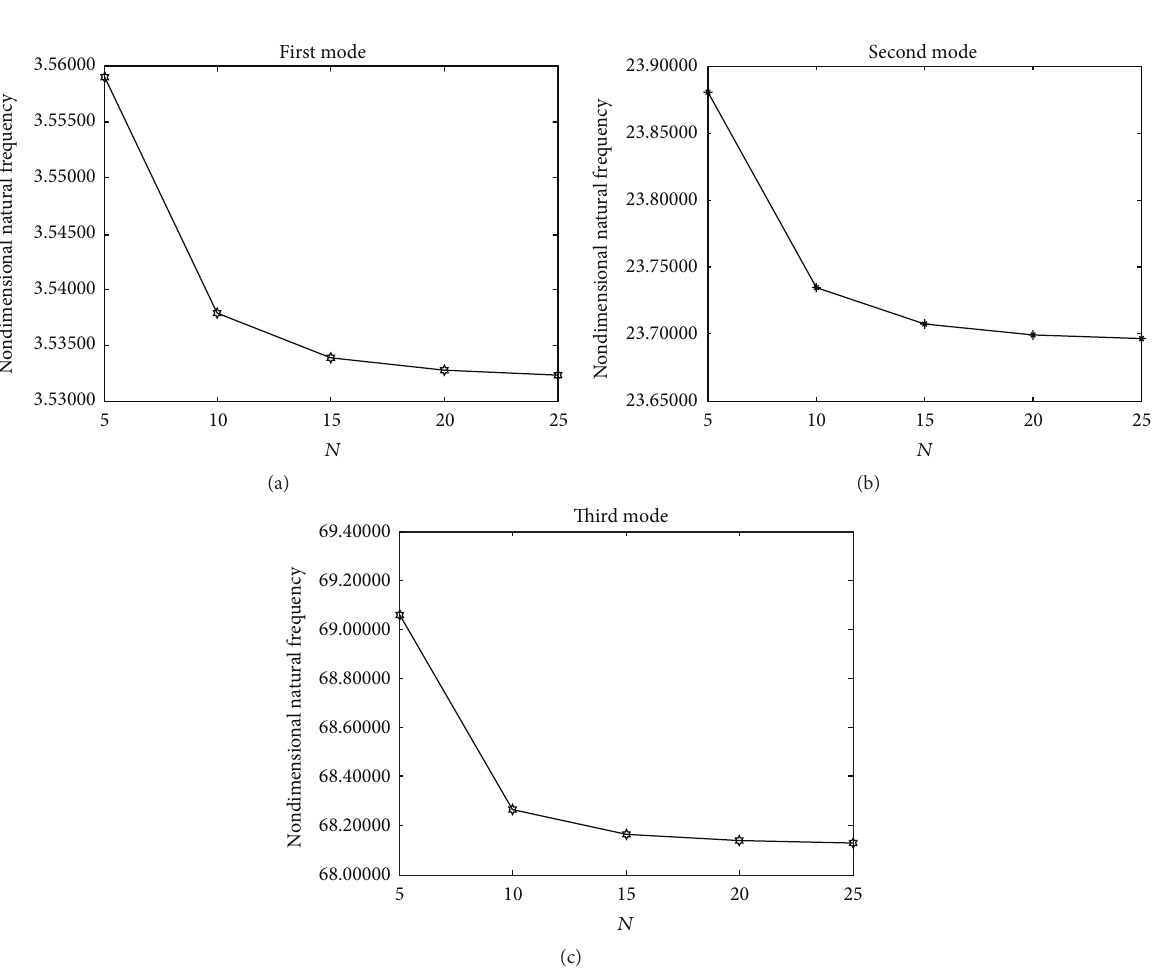
agree with those reported by Huang and Li [14] very well. The comparison of the results for Cases 1 and 2 listed in Tables 9 and 10 indicates that the gradient index 𝛼 is important for the natural